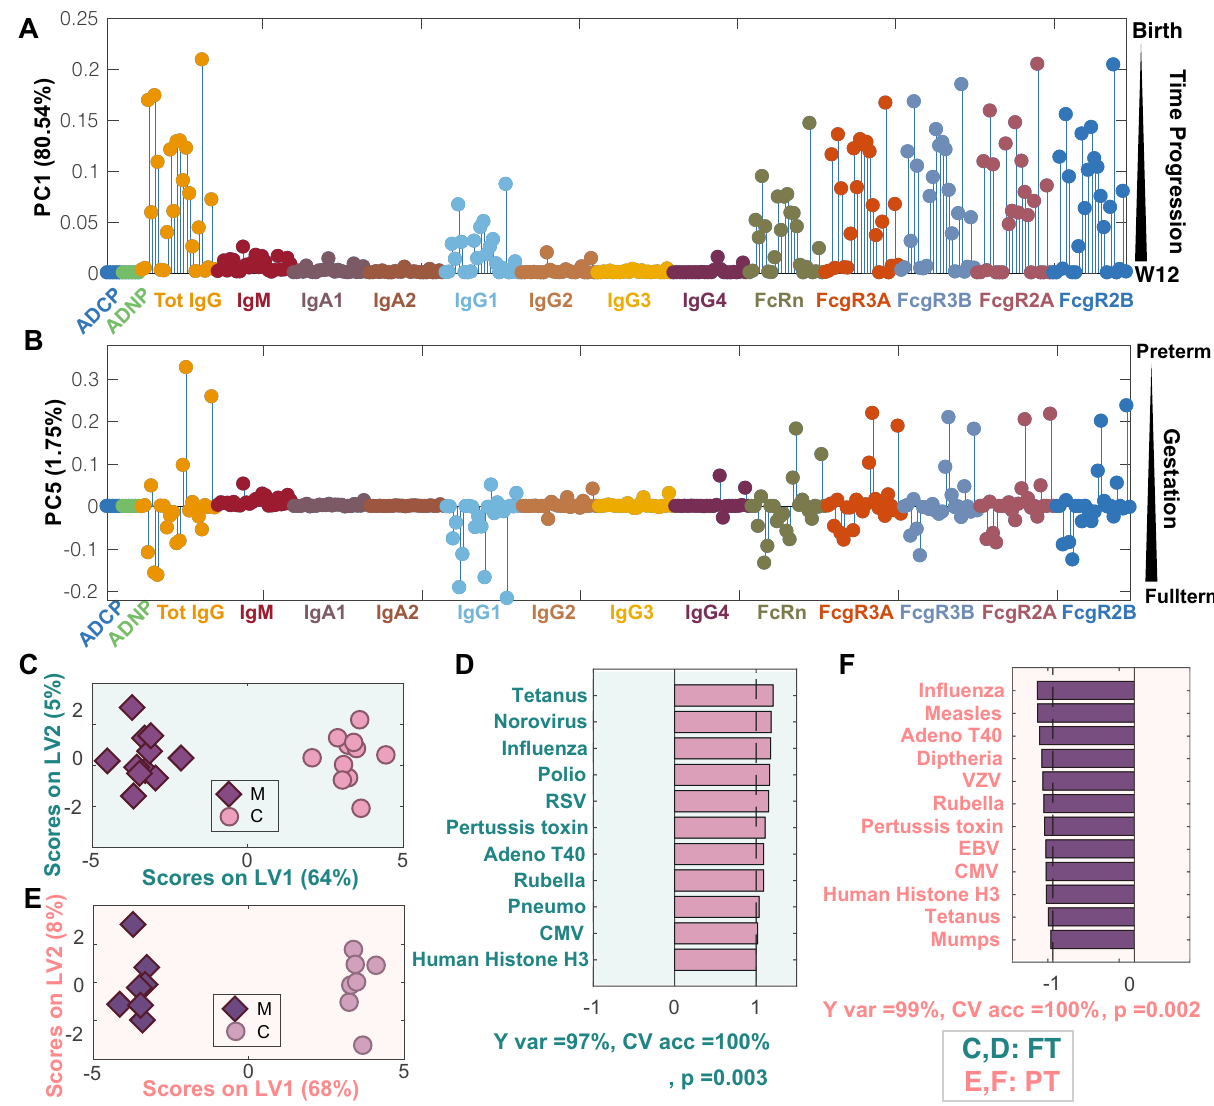
Figure 3. Antigen-specific transfer varies in PT infants. ( A , B ) The graphs depict the loading values on PC1 ( A ) and PC5 ( B ) of the PCA scores plot from Fig. 2. ( A ) Loadings on PC1 capture the changes over time. Each dot represents an antigen, and dot colors depict different Fc-readouts. ( B ) Loadings on PC5 reflect differences with gestational age. The order of antigens shown from left to right for all Fc measurements with the exception of ADCP and ADNP are: measles, mumps, rubella, pertussis toxin, influenza, VZV, polio, HepA, pneumo, Adeno T5, Adeno T40, Norovirus, Parvo VP2, tetanus, diphtheria, HSV1, HSV2, CMV, EBV, RSV, Human Histone H3, nArah2, nBosd8, nBetv1. Antigen specificities from left to right for ACDP: RSV, pneumo, pertussis toxin, rubella, influenza. Antigen-specificities for ADNP from left to right: rubella, pertussis toxin, influenza, pneumo, CMV, RSV. ( C ) ML-PLSDA depicts the antigen-specific differences across FT maternal:cord pairs. The model was orthogonalized such that the separation of maternal and cord antibody profiles was captured on Latent Variable 1 (LV1), capturing 83% of the Y-variation. Conversely, LV2 captures the variability in the antibody features that do not contribute to the separation (Y var = 0%). ( D ) The bar graph depicts the VIP scores for loadings on LV1. Only the top contributors to the separation with VIP score > 1 are shown, all of which are higher in cord blood. A fivefold cross validation (CV) of the model resulted in CV accuracy of 85%. This model outperformed 93% of label-shuffled random models (Wilcoxon p = 0.07). ( E ) The ML-PLSDA scores plot depicts differences in antibody profiles in maternal:cord PT pairs. In this orthogonalized model, the separation of PT maternal and cord antibody profiles was captured on LV1, capturing 73% of the Y variation. LV2 captures 0% of Y var variation. ( F ) VIP scores for loadings on LV1 (VIP scores > 1) highlight higher antigen-specific antibody levels in maternal plasma. A fivefold cross validation of the model resulted in a CV accuracy of 69%. The model outperformed 85% of models based on randomly label-shuffled inputs (Wilcoxon p =